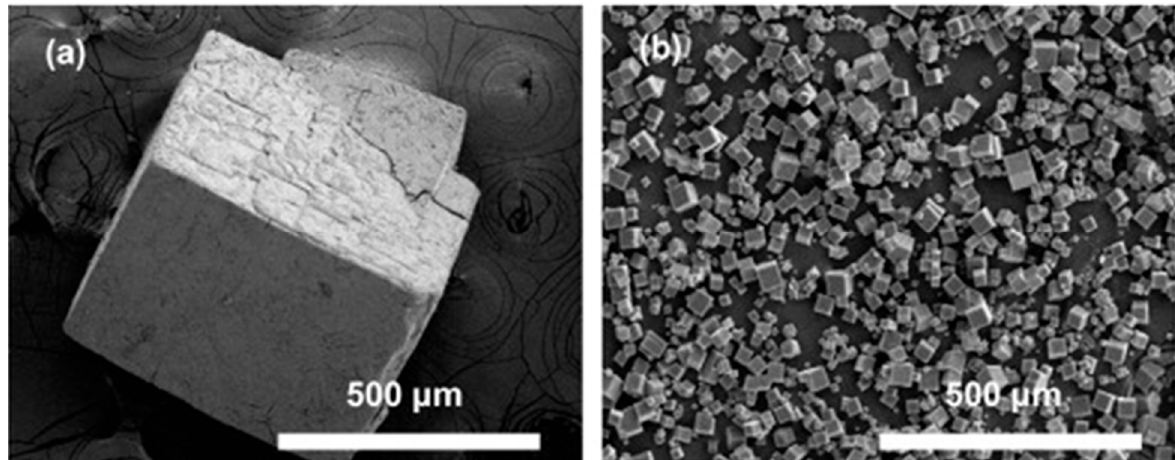
Figure 3. Scanning electron microscopy (SEM) images of MOF-5 crystals obtained using ( a ) conventional and ( b ) microwave- assisted approaches [118].